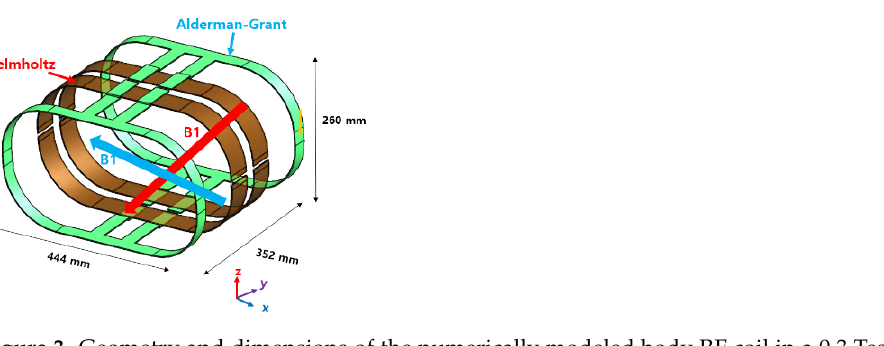
Figure 4. Circularly polarized (CP) excitation magnetic field (B 1 in Tesla) of the body RF coil model under the unloaded condition. 2.2. Human Body Model Two numerical human body models representing young patients were placed on the patient table of the open MRI system. Billie, one of the patient models, is an 11-year-old female model, with 75 different biological tissues. Thelonious, the other patient model, is a 6-year-old model of a male patient with 76 different tissues with dielectric properties at 13 MHz. As the patient assistant, a posable adult model (Duke) was employed. Duke is a model of a 34-year-old male with 77 different tissues. The human body models are sum- marized in Table 1. Because Duke is a posable model, various poses were possible near the patients, allowing the RF exposure conditions to be examined at different poses of the patient assistant during the MRI scans. Five poses were defined using the Duke model, which are representative scenarios, as described in more detail in the next section. These three human body models are available from the Foundation for Research on Information Technologies in Society (IT’IS) [23,24]. The dielectric tissue properties at 13 MHz, pro- vided from the IT’IS database [25], were applied to all human body models. The IT’IS database includes experimentally measured tissue properties as determined by Gabriel et al. [26]. Table 1. Human body models. Name